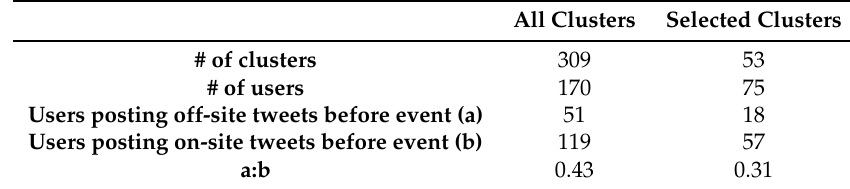
Table 3. Geospatial patterns.